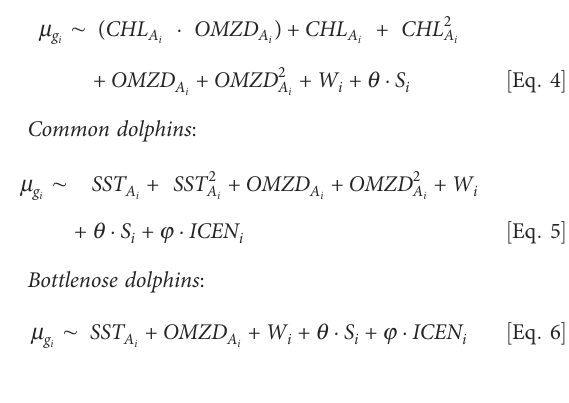
(Table 1). The best models for each species were: Dusky dolphins